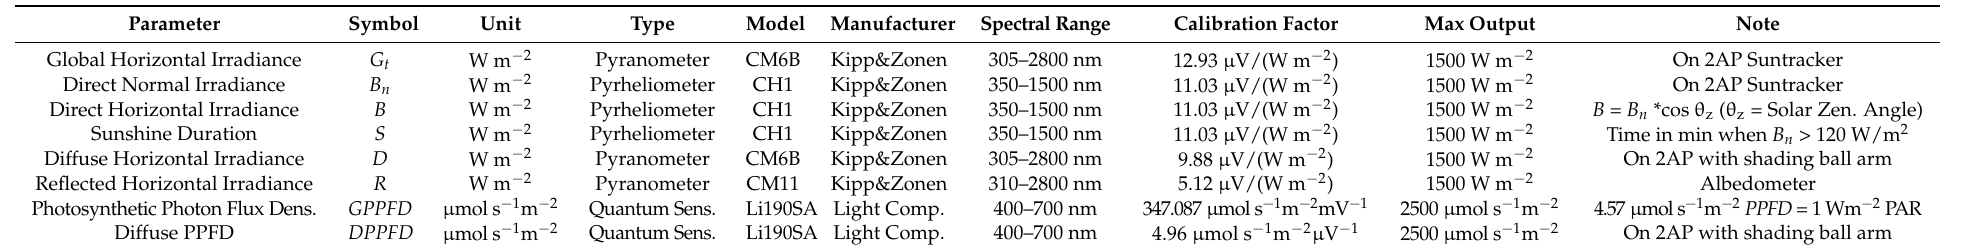
Table 2. Solar Shortwave Radiation equipment installed at the actinometric station of